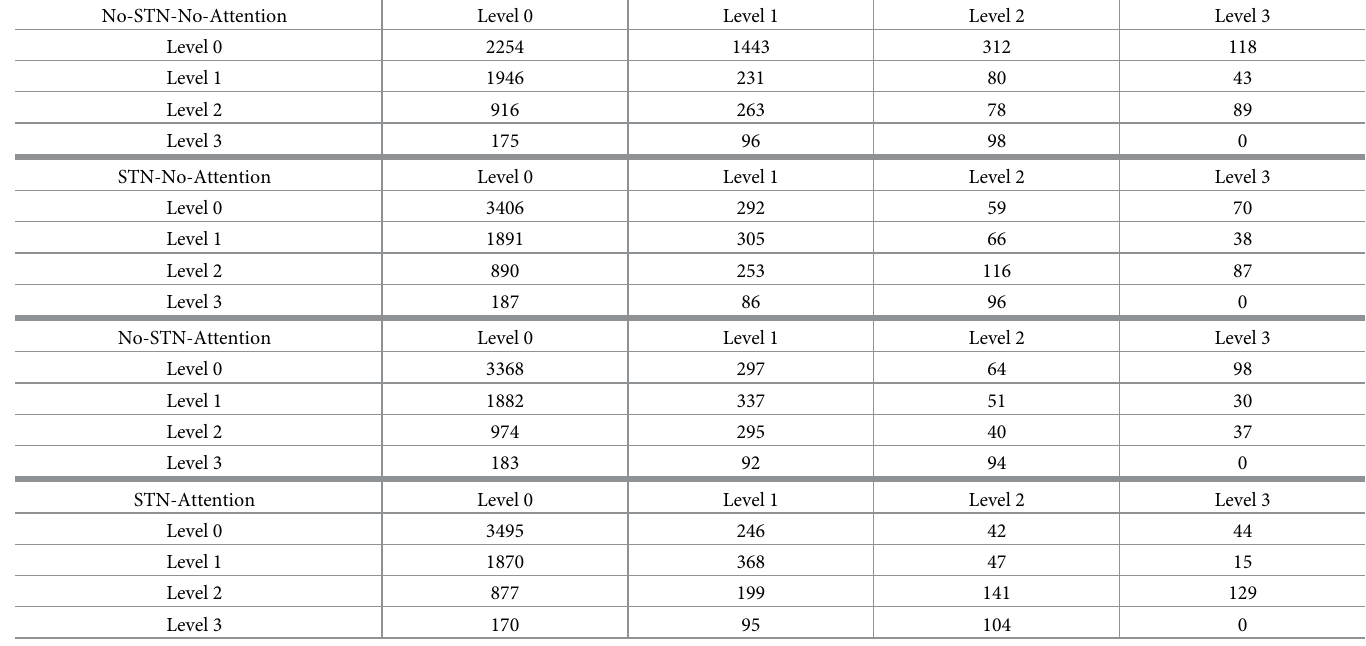
Table 5. Confusion matrixes of different modes of the proposed